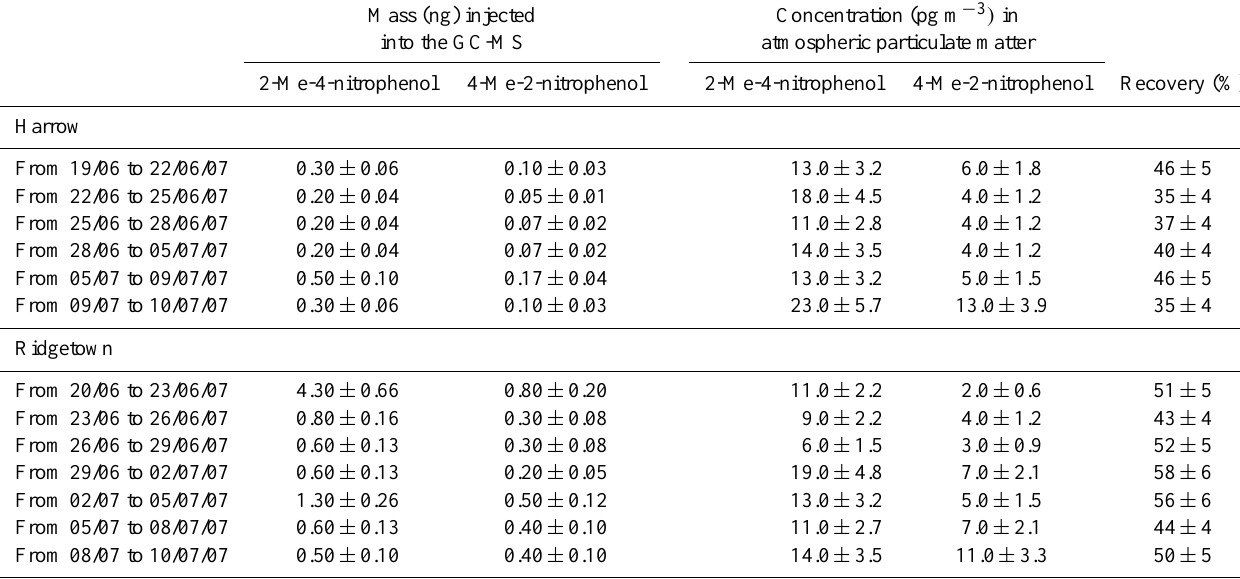
Table 5. Mass (ng) of 2-methyl-4-nitrophenol and 4-methyl-2-nitrophenol in 1µl of the final solution from extraction of filters collected at Harrow and Ridgetown during BAQS and the corresponding concentrations in the atmosphere.